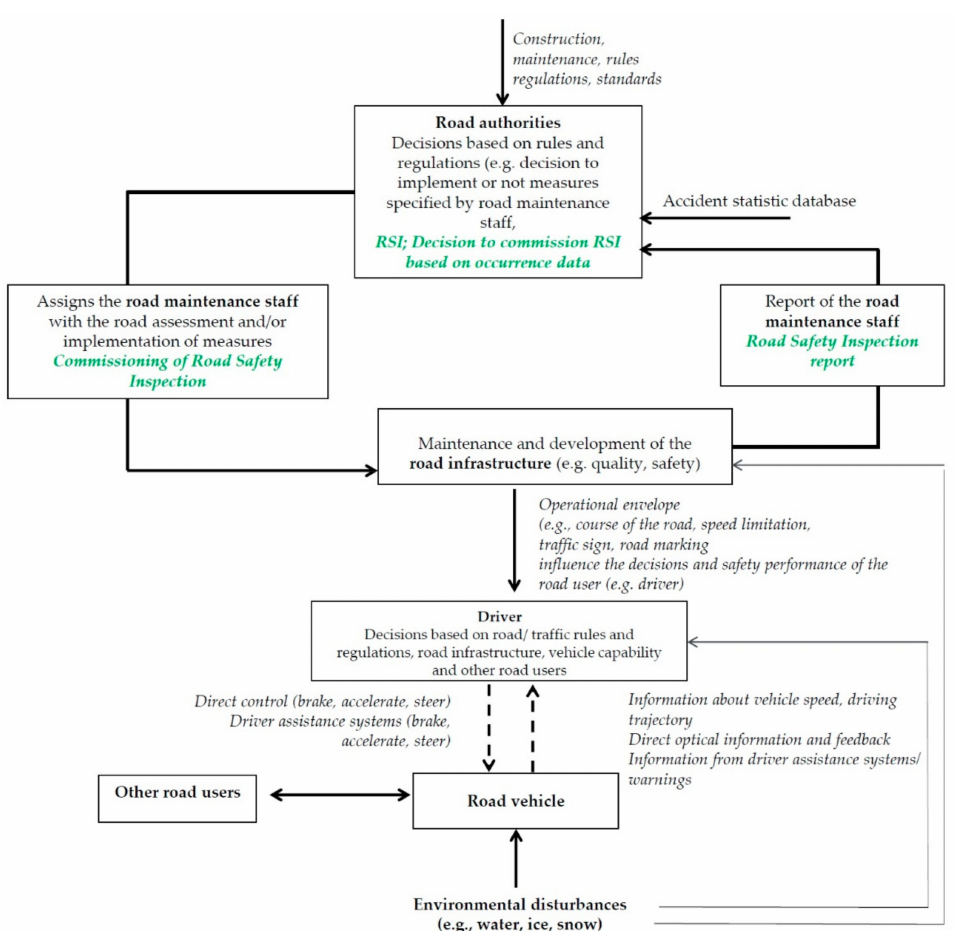
Figure 1. Hierarchical control structure model of the existing road system in Austria, STPA Step